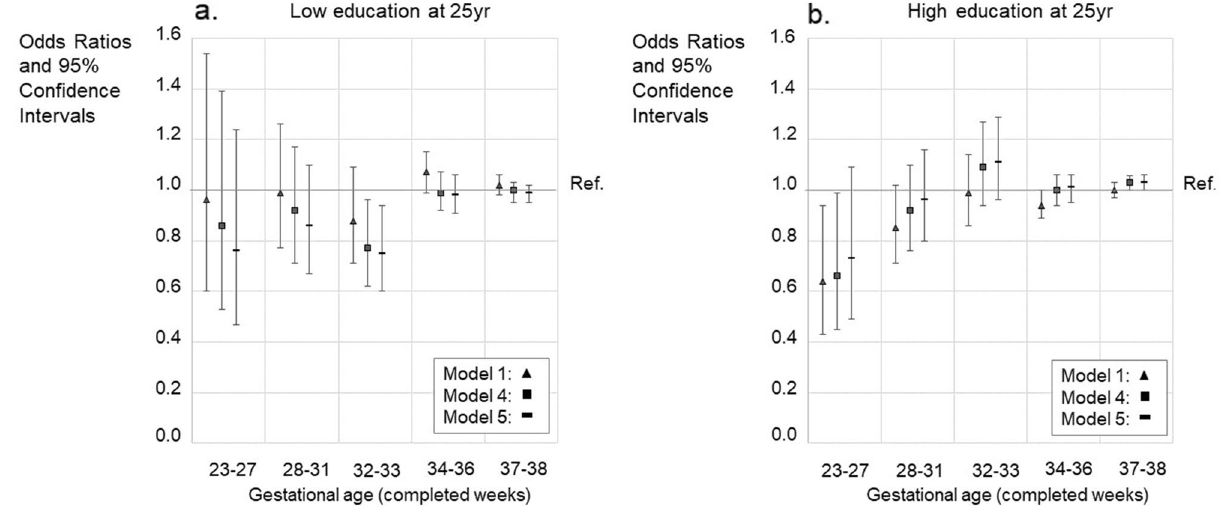
Figure 4. Education at 25 years of age. Intermediate education (upper secondary, less than tertiary) as a reference. A - Odds ratios (OR) with 95% confidence intervals for low education (basic only or unknown). B - Odds ratios (OR) with 95% confidence intervals for high (lower tertiary or more) education. The figure shows models 1, 4, and 5. Models 2 and 3 are available in the Supplementary Table 9ab. GA category 39–41 weeks is the reference group (with OR = 1.0). Only such individuals who attended mainstream education in compulsory education are included. Model 1; Unadjusted model, Model 4; Adjusted for the sex, birth year, maternal and paternal ages, maternal and paternal highest attained education, BWSDS, gestational disorder(s), maternal smoking at pregnancy, maternal marital status at the childbirth, and birth order, Model 5; Adjusted as Model 4, and for severe medical